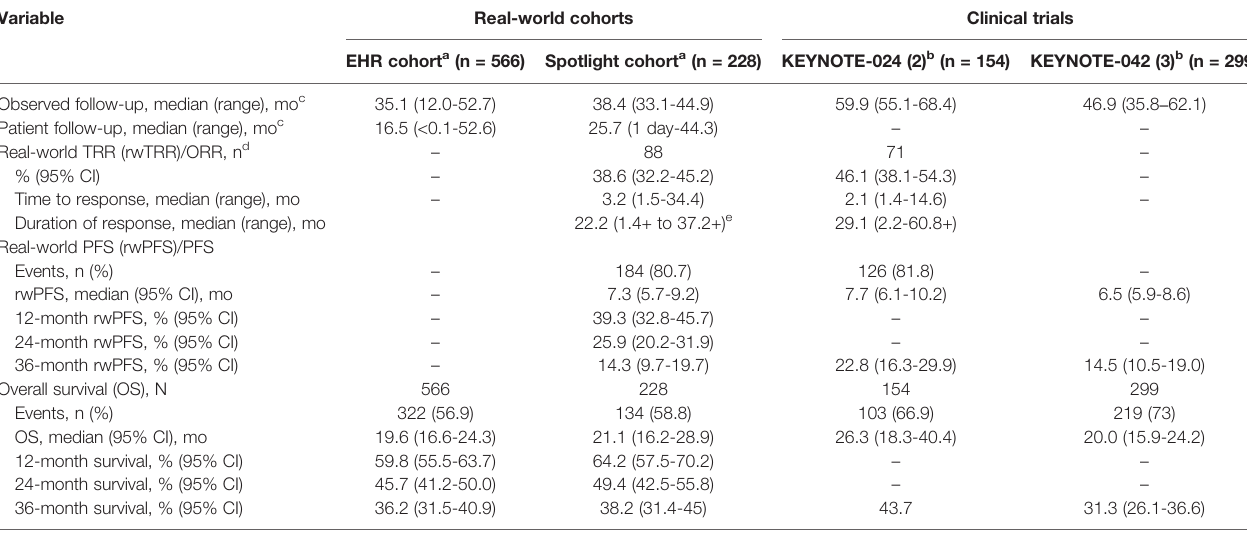
TABLE 2 | Outcomes with fi rst-line pembrolizumab monotherapy in the real-world oncology and clinical trial settings. Variable Real-world cohorts Clinical